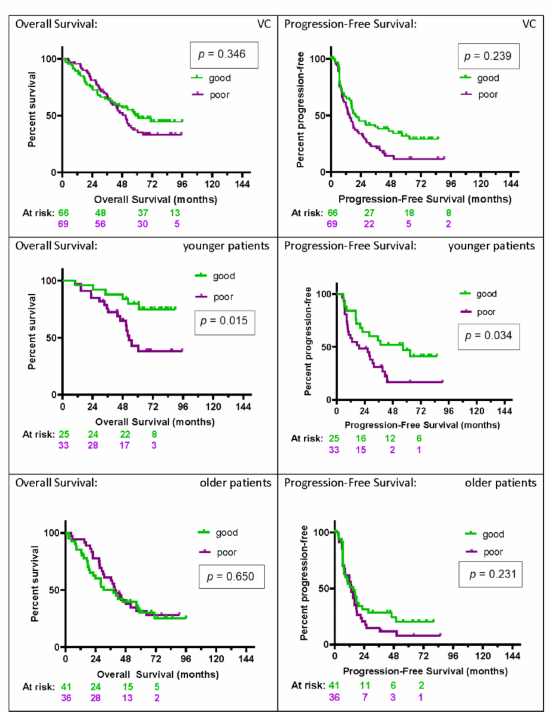
Figure 4. KM plots by test classification (good vs. poor) of overall and progression-free survival for the validation cohort (VC): overall (VC, n = 135) and for younger patients (age ≤ 55, n = 58) and older patients (age ≥ 56, n = 77) separately. The number of patients at risk in the KM analysis at two-year intervals in each test classification group (green = good, and purple = poor) is shown below the x -axis. Comparing good versus poor in the group of older patients (age ≥ 56; n = 77), we see that the test was unable to stratify PFS or OS. OS was similar for good and poor groups ( p = 0.650). Median survival was 40 (95% CI: 29–57) months for the poor group and 38 (95% CI: 19–57) months for the good